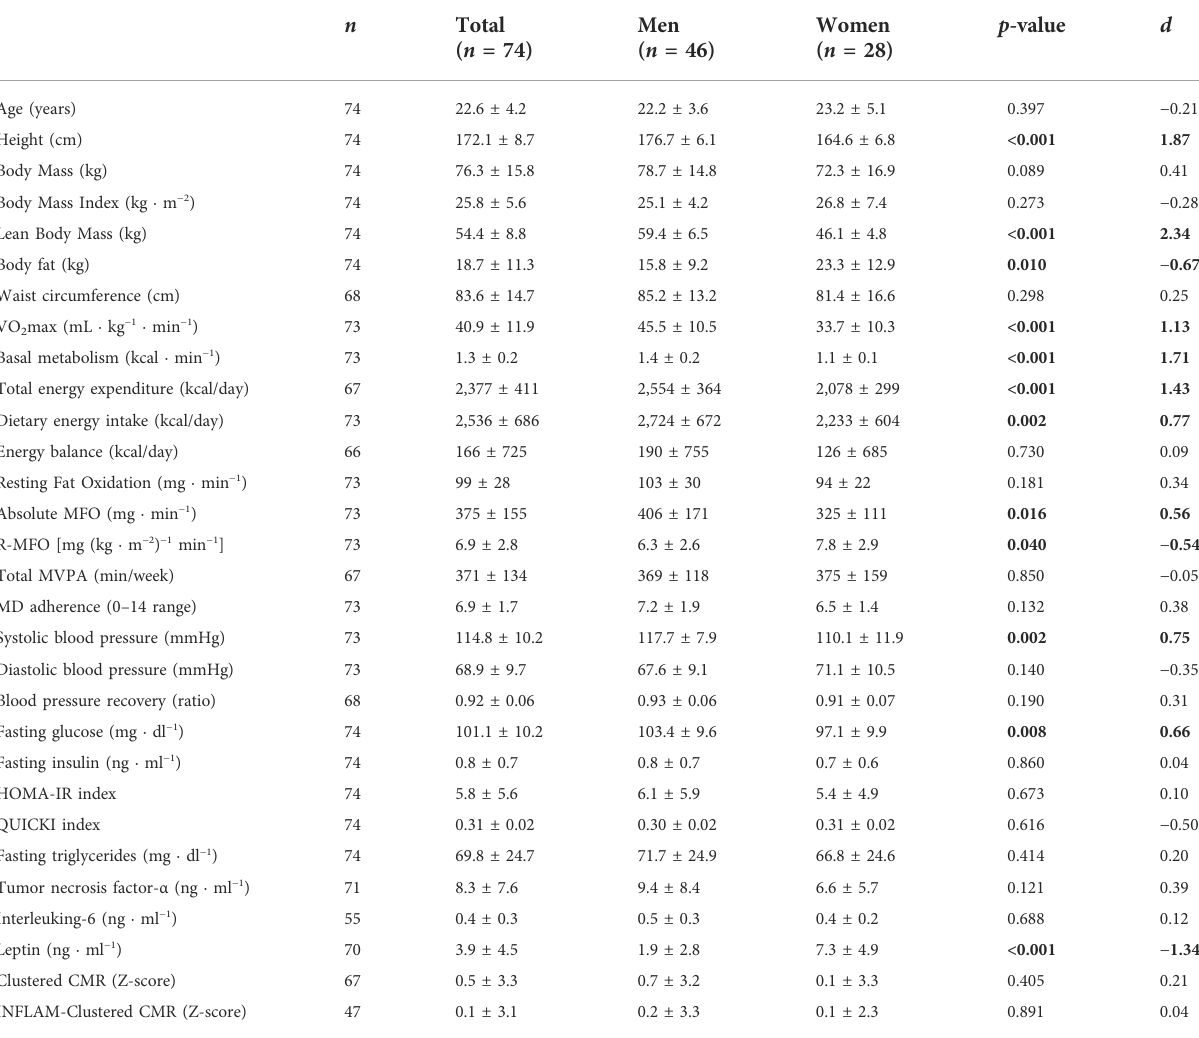
TABLE 1 Participants ’ characteristics and differences between